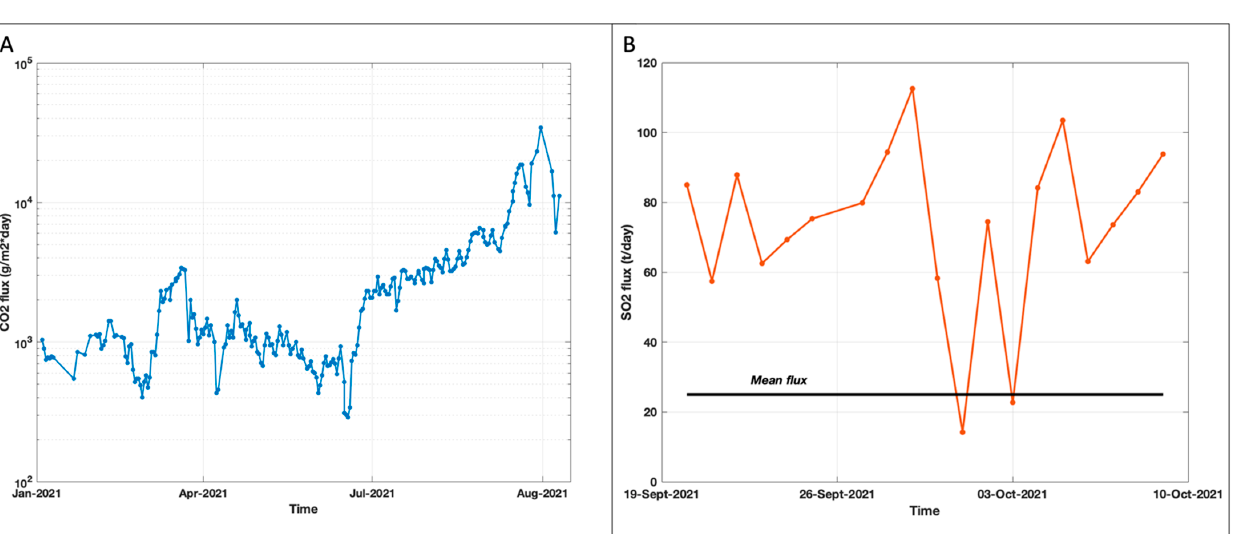
Figure 3. Daily frequency of micro-shocks (peak frequency between 1 and 30 Hz) that characterizes the local seismicity of Vulcano in the last year. A significant increase in seismicity is evident in the right end of the graphic.